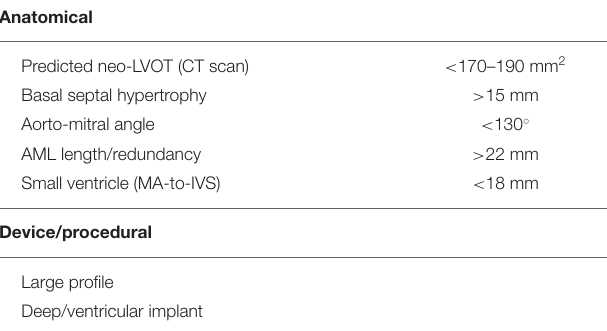
TABLE 3 | Risk factor for LVOT